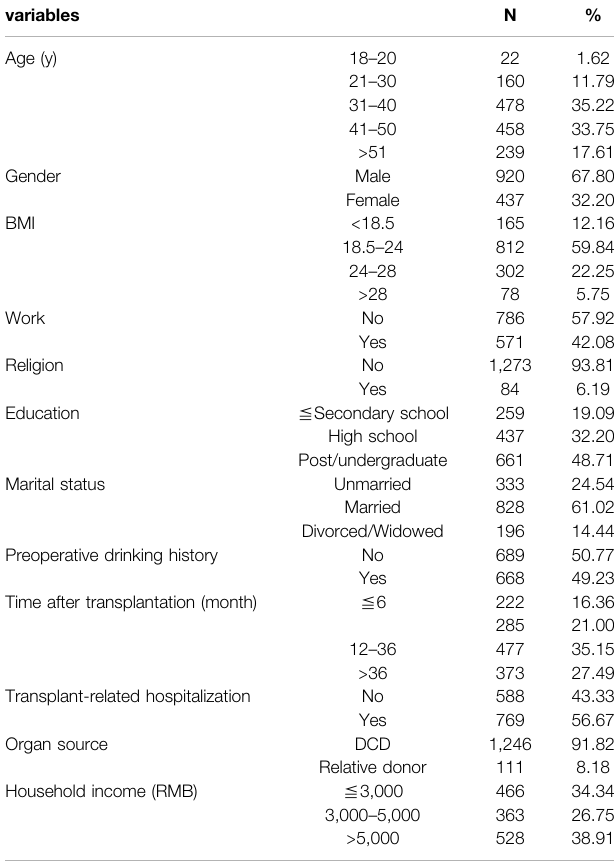
TABLE 1 | Sociodemographic characteristics of RTPs (n (cid:2) 1,357). variables